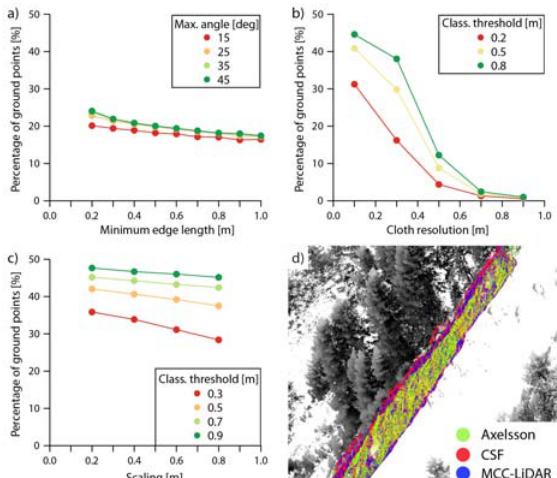
Figure 9. Results of the parameter tests using the Axelsson filter (progressive TIN densification, a), the cloth simulation filter (CSF, b) and the MCC-LiDAR algorithm (c) and a comparison of the results along a profile (d).